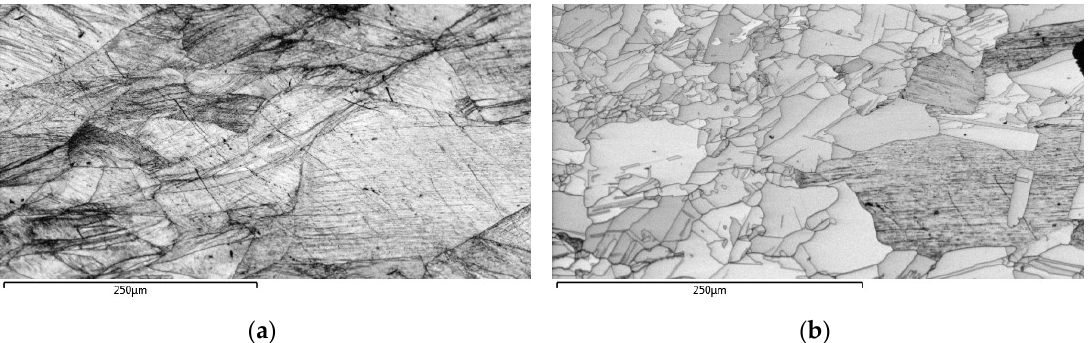
Figure 8. Band contrast EBSD images for the ( a ) cold deformed sample with 160 µm mode gran size (0.3 strain) and ( b ) partially recrystallised sample after reheating at 700 °C for 60 min showing the coarse grain remains unrecrystallised whilst the fine grain region recrystallised.